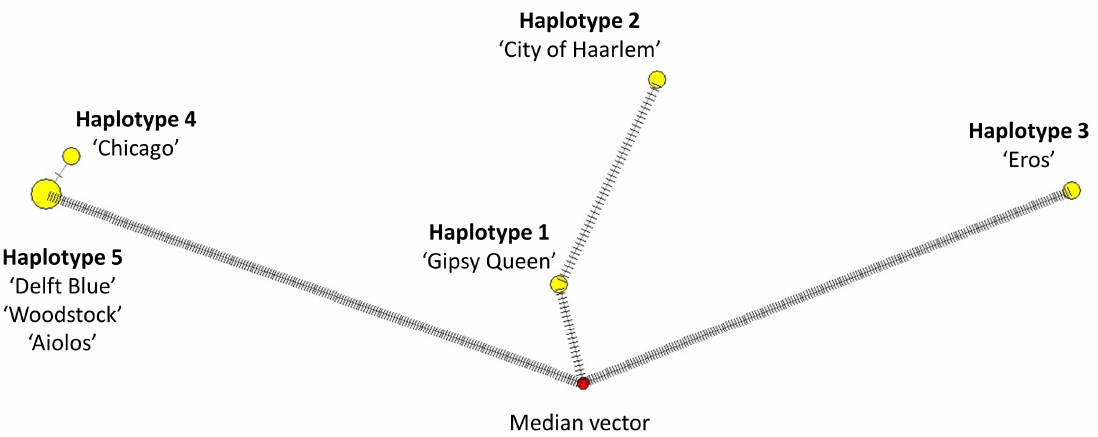
Figure 11. Median-joining network of the seven Hyacinthus cultivars. Median vector represents the sequences of cultivars, which are extinct ancestors or not sampled in this study. One hedgemark represents one variable site between the linked